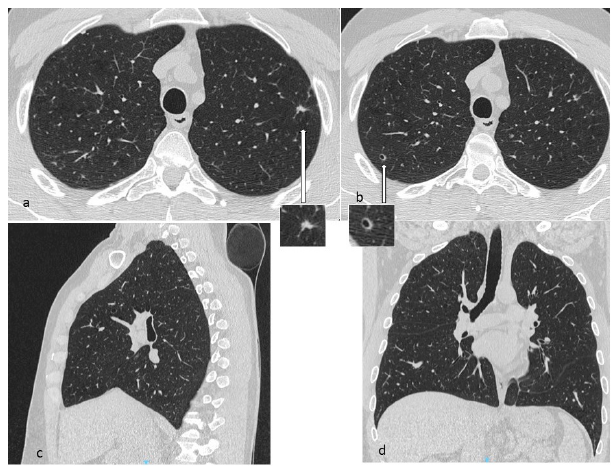
Figure 1. In LCH, cysts may origin from the cavitation of nodules ( a , b ) and can be isolated or confluent, and are mainly located in the middle and superior lobes, with typical sparing of costophrenic angles. Multiplanar reconstruction (MPR) in the sagittal ( c ) and coronal plane ( d